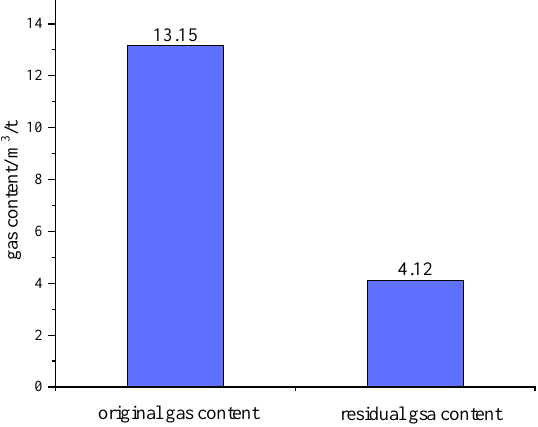
Figure 20. Gas content of protected layer before and after mining.